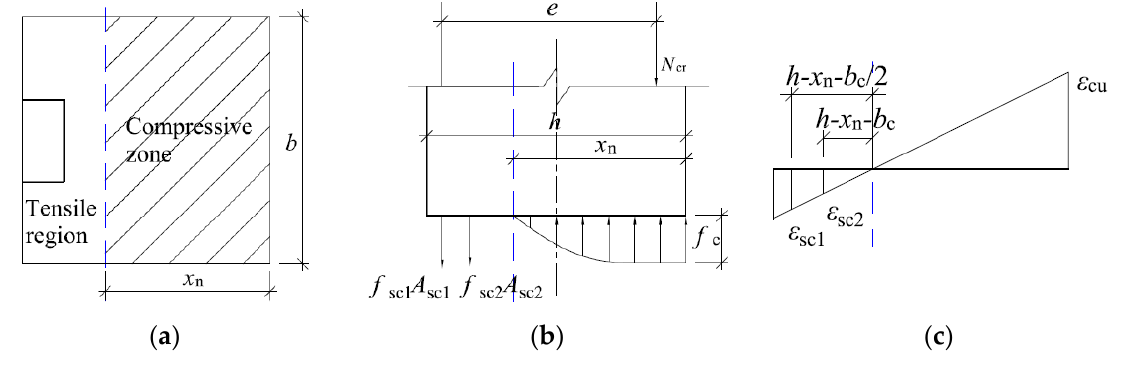
Figure 11. Sketch of the calculation when the specimen is damaged by the channel reinforcement method. ( a ) Cross-sectional view during crush damage; ( b ) Cross-sectional stress distribution during crush damage; ( c ) Cross-sectional strain distribution during crush damage.